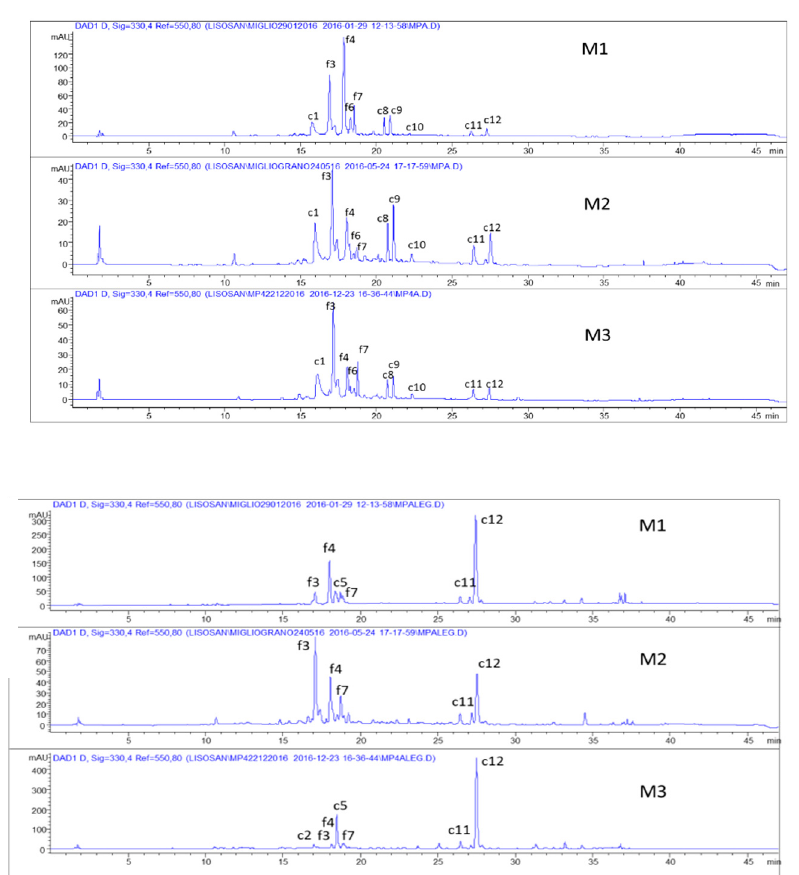
Figure 1. Chromatographic profiles at 330 nm of the free phenols ( a ) and total phenols obtained after basic hydrolysis ( b ) of the millet batches (M1, M2, M3). The identified compounds are listed in Table 1; c = cinnamic derivatives; f = flavonoids. Table 1. List of the identified compounds in millet